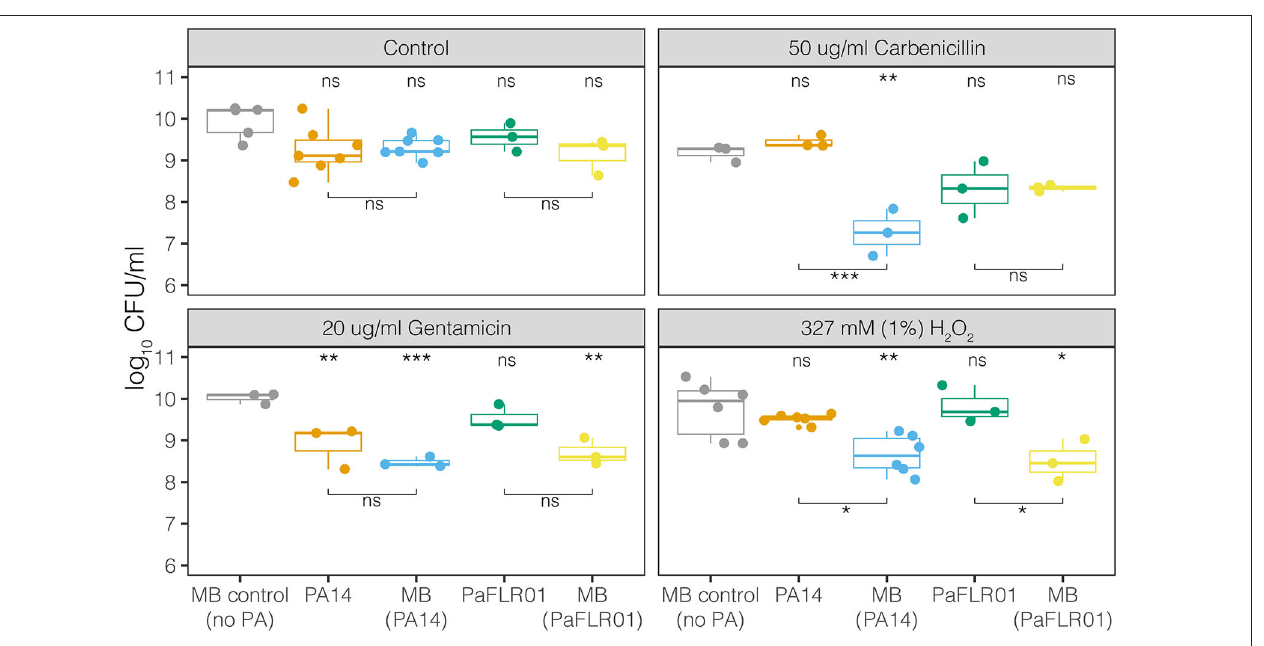
FIGURE 3 | Growth, in CFU/mL, of MB alone, P. aeruginosa strains [PA14, PaFLR01] and their corresponding MB communities [MB(PA14), MB(PaFLR01)] in the perfused media meat model. Each point is a biological replicate and represents the average of > 3 technical replicates from dilution plating. N ≥ 3 biological replicates for all conditions. Statistical testing was performed with ANOVA with post-hoc Tukey tests. Significance is indicated by asterisks. The asterisk and “ns” indicators on the top of the graph are significance tests of each population vs. the MB control (no PA). The asterisks and “ns” indicators with bars below the data are comparisons between the populations connected by the bars. ns p > 0.05; * p < 0.05; ** p < 0.01; *** p <